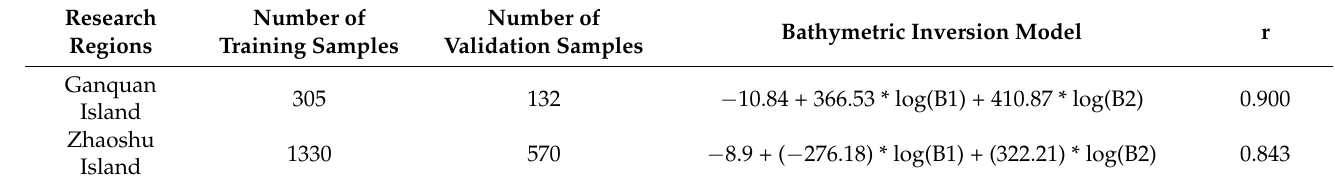
Table 6. Information of the DLR